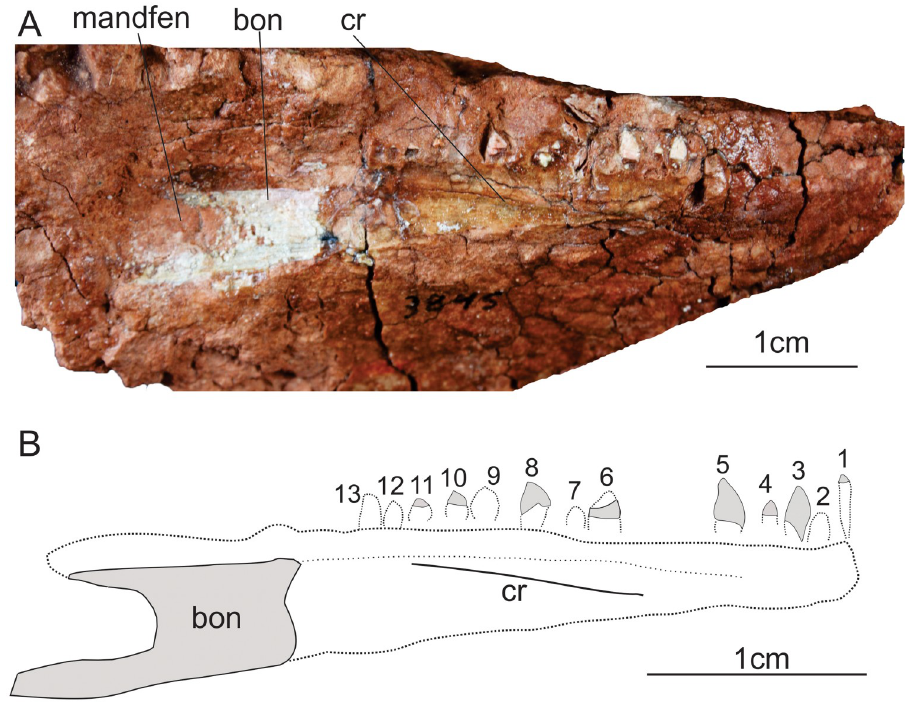
Fig 9. Left dentary of the specimen MCP-3845-PV of Saturnalia tupiniquim in medial view (A) and interpretative drawing (B). Abbreviations : bon: preserved bone; cr—crest; mandfen— mandibular fenestra; tocr— tooth crown; 1 to 13 —preserved tooth